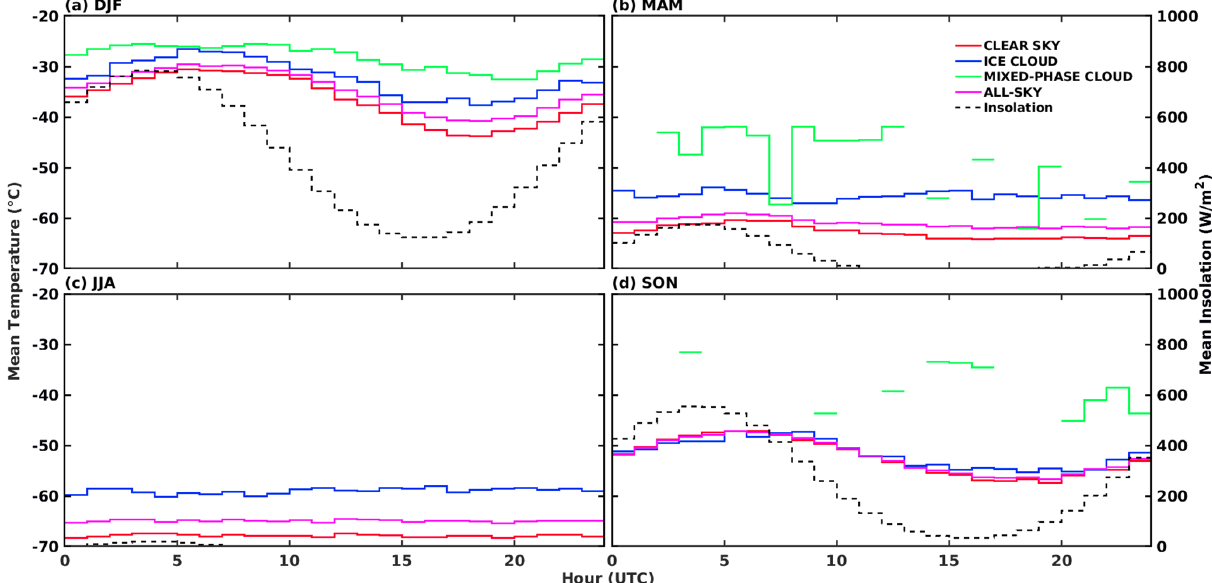
Figure 12. Hourly mean surface air temperature, according to the sky condition: clear sky (red line), ice clouds (blue line), mixed-phase clouds (green line), and all sky (magenta line). The temperature is reported according to the season: (a) DJF, (b) MAM, (c) JJA, and (d) SON. The top-of-the-atmosphere hourly mean insolation is also reported in Wm − 2 (dashed black line), and values are indicated by the ordinate axis on the right. Local time is UTC +